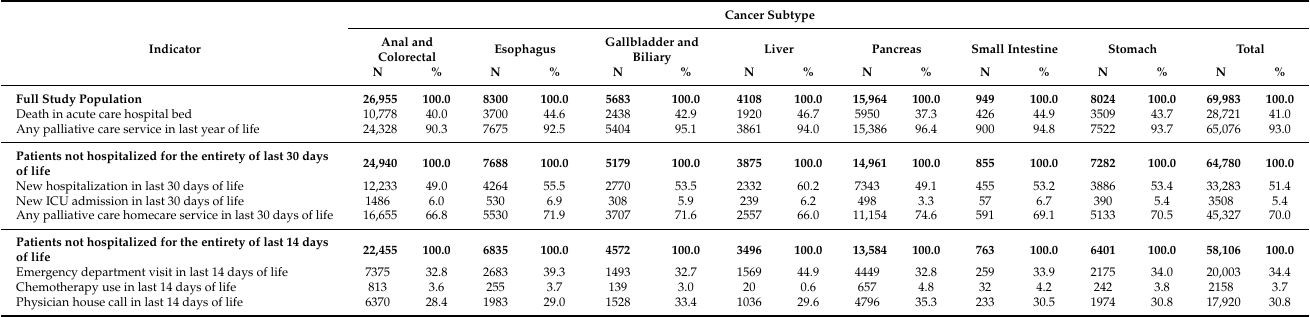
Table 2. Quality indicator rates by GI malignancy subtype.